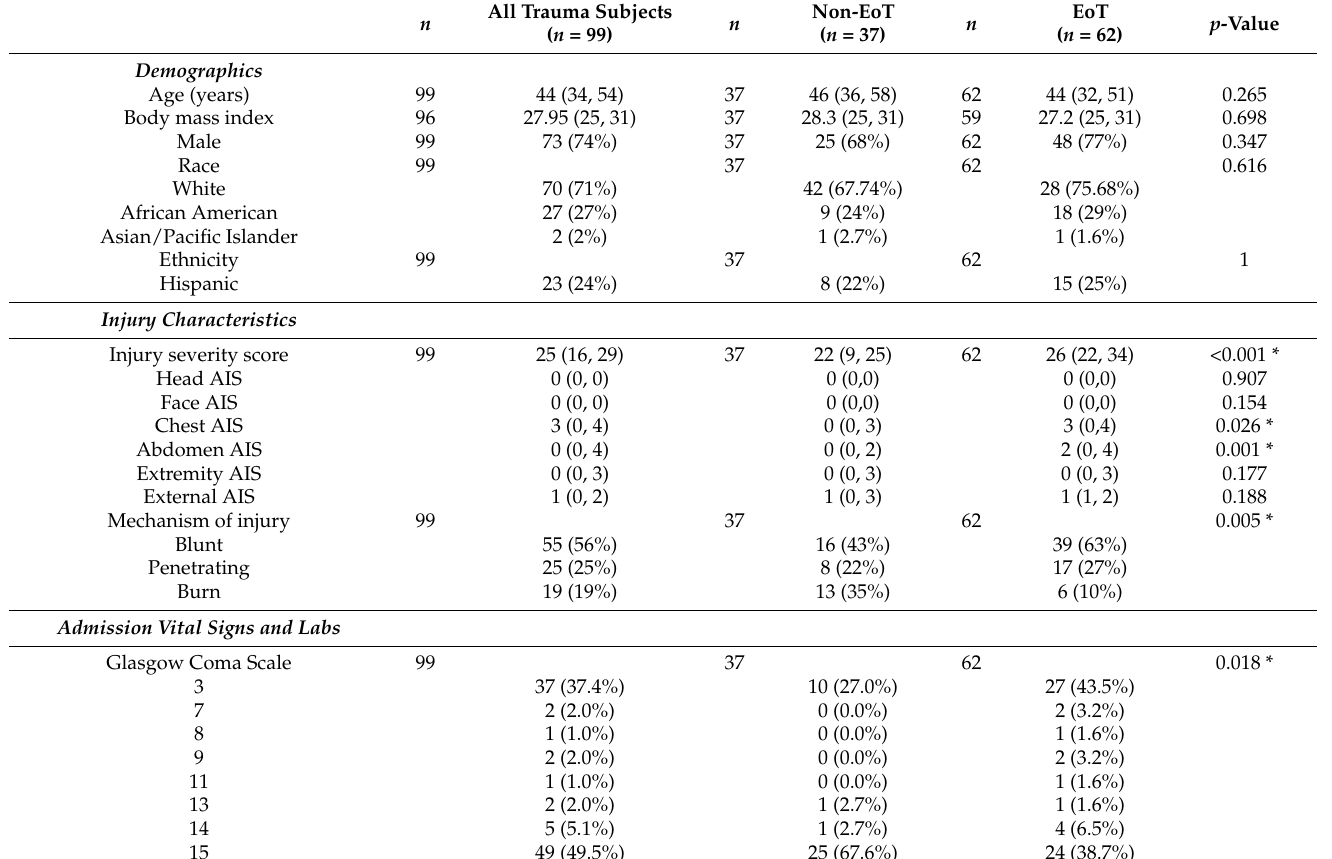
Table 1. Demographics, clinical data, laboratory values and outcomes of trauma patients by EoT status. Data are presented as the median (IQR) for continuous variables and n (%) for categorical and ordinal